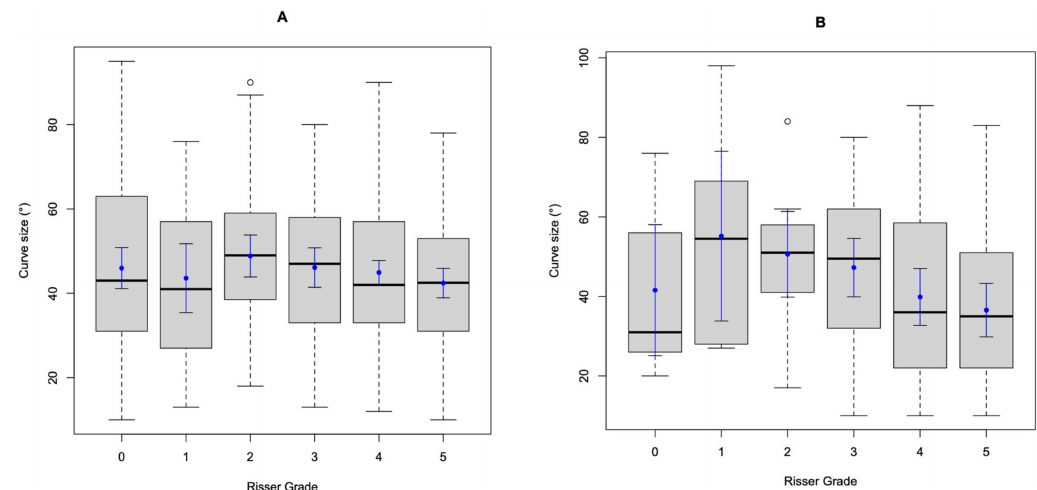
Figure 2. ( A , B ) The size of the curve stratified by Risser grade for females ( A ) and males ( B ) as box and whisker plots. The heavy line in the box is the median value, with the box representing the interquartile range (IQR). The whiskers represent 1.5 times the IQR, and all data outside of the whisker are represented as an open circle. The solid blue circle is the mean, and the bars from that circle are the 95% confidence intervals of the mean. Table 2. The number of individuals suitable for bracing, as per the Scoliosis Research Society (SRS) and British Scoliosis Society (BSS) criteria [14,15]. Statistical Significance Female Male between Females and